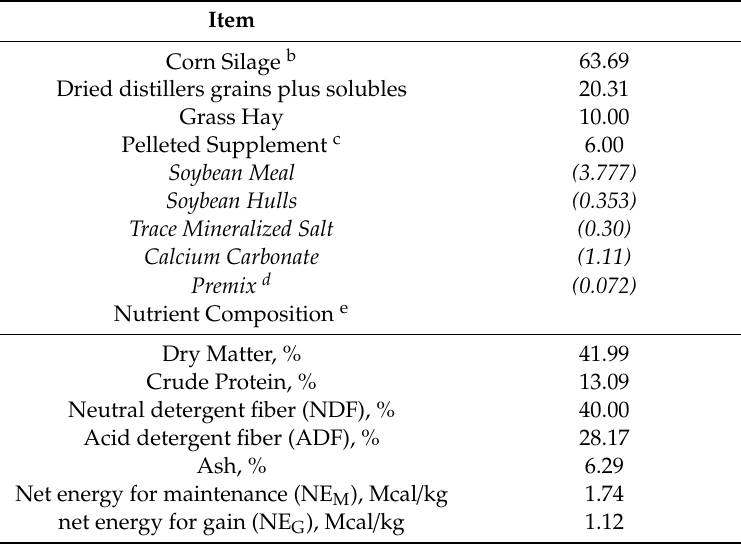
Table 2. Experiment 2: Diet composition (DM basis) a